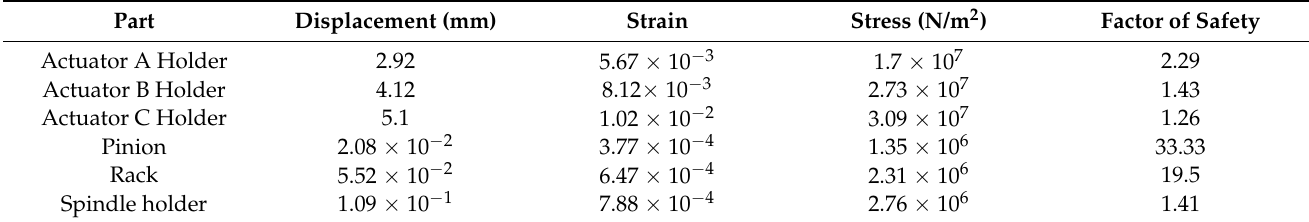
Table 1. FEA results of all developed parts within the mechanical